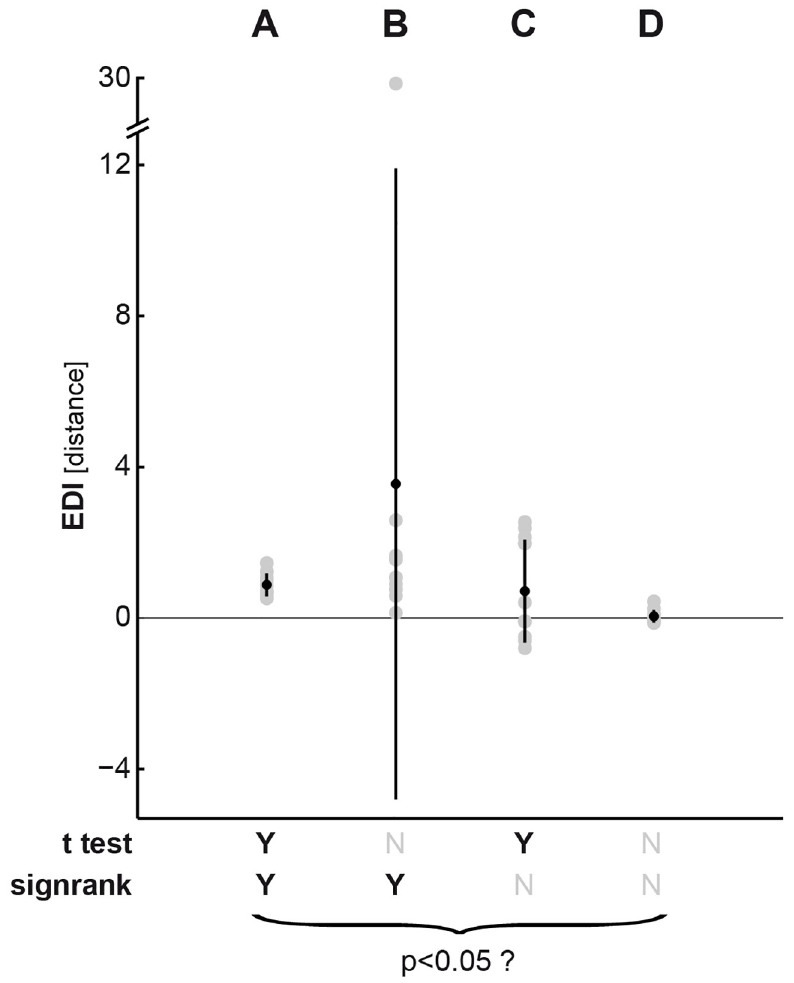
Fig 3. t test and Wilcoxon signed-rank tests examine different null hypotheses about the data distribution. The graph depicts four different sets of simulated EDIs (A to D) sampled from Gaussian distributions with different means and variances. Gray points indicate the sample data. The superimposed black point depicts the mean of each sample. The sample variance around its mean is depicted by black lines emanating from the mean ( i . e ., the black dot). Each set consists of 12 values, representing 12 subjects, which are submitted to both a t test and a Wilcoxon signed-ranked test. Both tests are right-tailed (meaning the tail extending into the positive direction) and test the null hypothesis that the data come from a distribution with zero mean (meaning no exemplar information across participants). p-values were pronounced significant (Y) if they passed the conventional threshold of p < 0.05. Otherwise, they were unsignificant (N). (A) The sample mean is positive and the sample variance is small, hence both tests pass the significance threshold. (B) The sample mean is positive. However, an extreme value in the sample inflates the variance. Therefore the t test does not return a significant p-value anymore. (C) The mean is positive, but the sample contains a considerable number of negative EDIs. Accounting for the weight of the ranks of the data points, the Wilcoxon-sigend rank test penalizes this presence of negative data points, therefore its p-value does not pass the significance threshold. (D) The sample mean is close to zero, hence neither test indicates significant exemplar information.